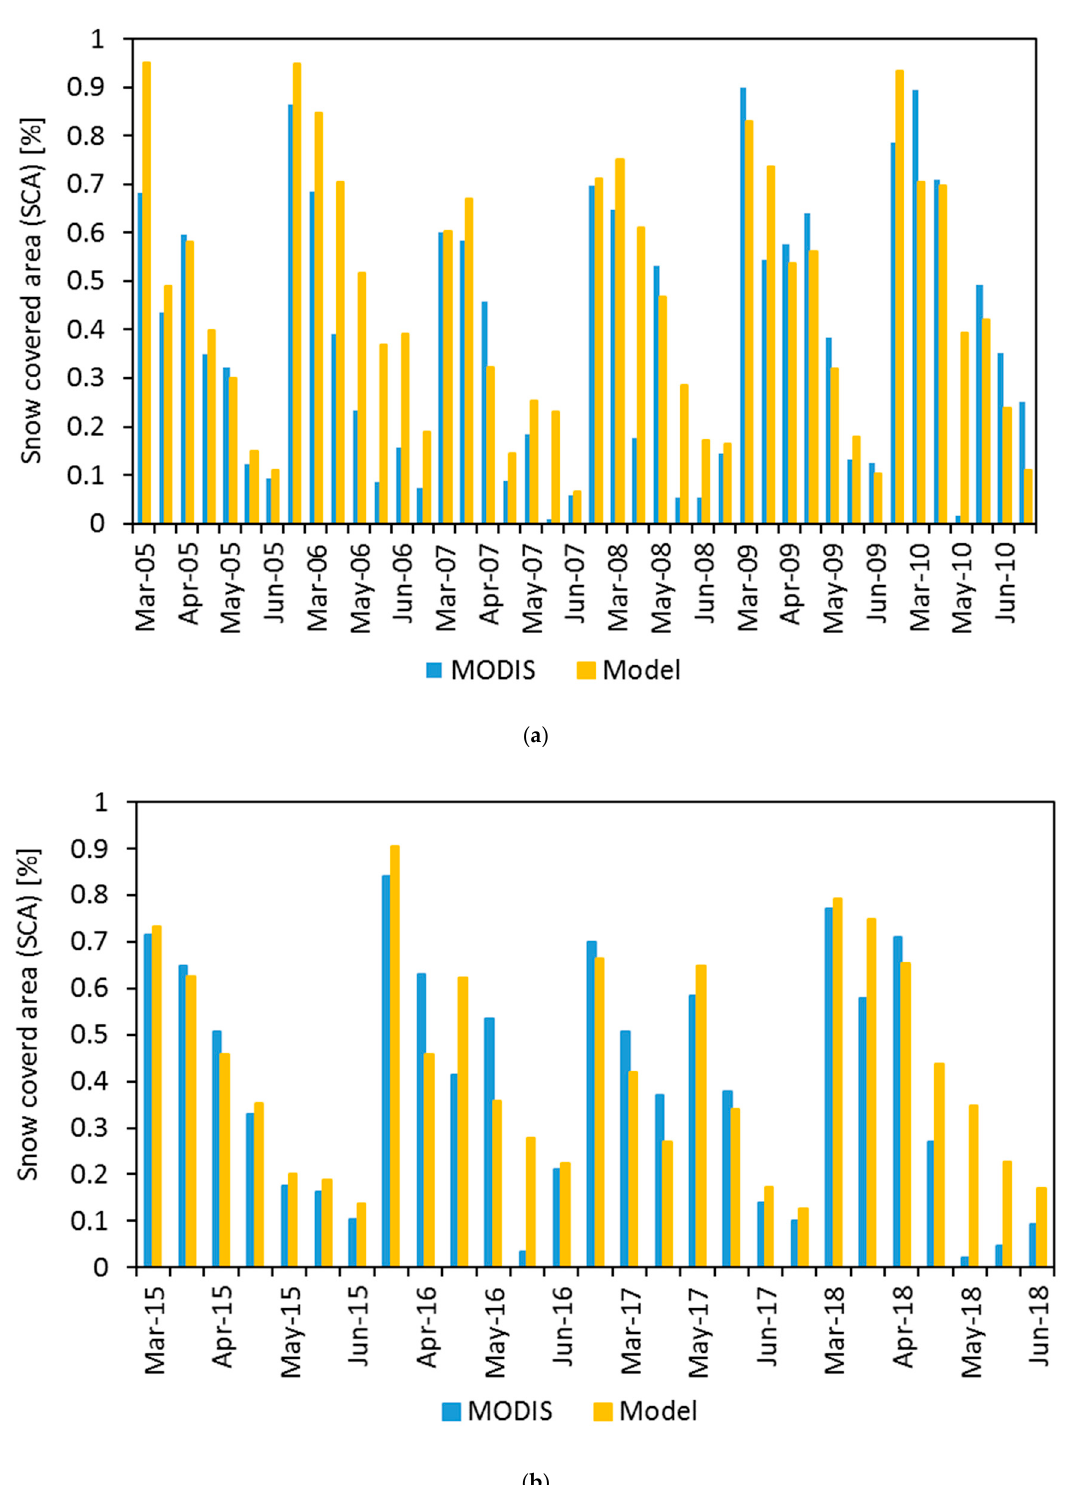
Figure 3. Snow covered area from the Poli-Hydro model vs MODIS estimates. ( a ) calibration. ( b ) validation.